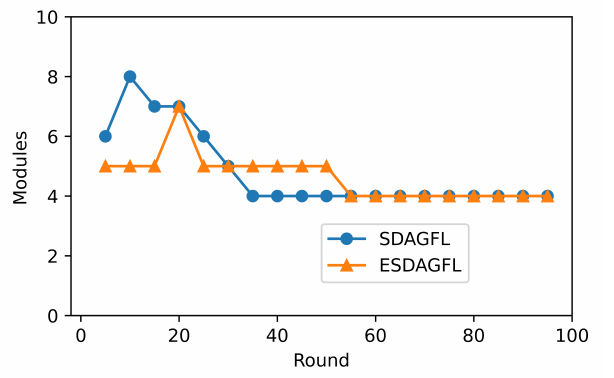
Figure 7. The modularity variation in ESDAGFL and SDAGFL evaluated on the FMNIST-clustered dataset.